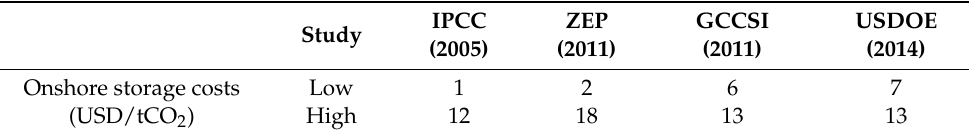
Table 13. Onshore storage costs on a standard basis (2013 USD/tCO 2 ) (adapted from